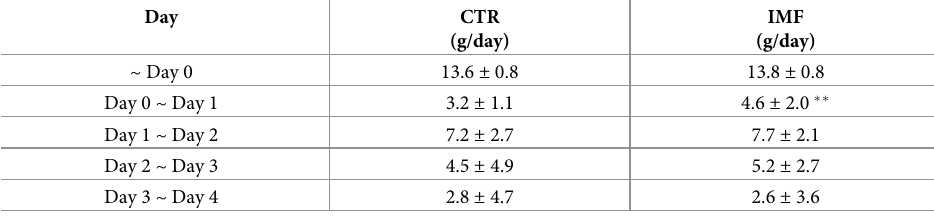
Table 2. Food intake after 5-FU injection.